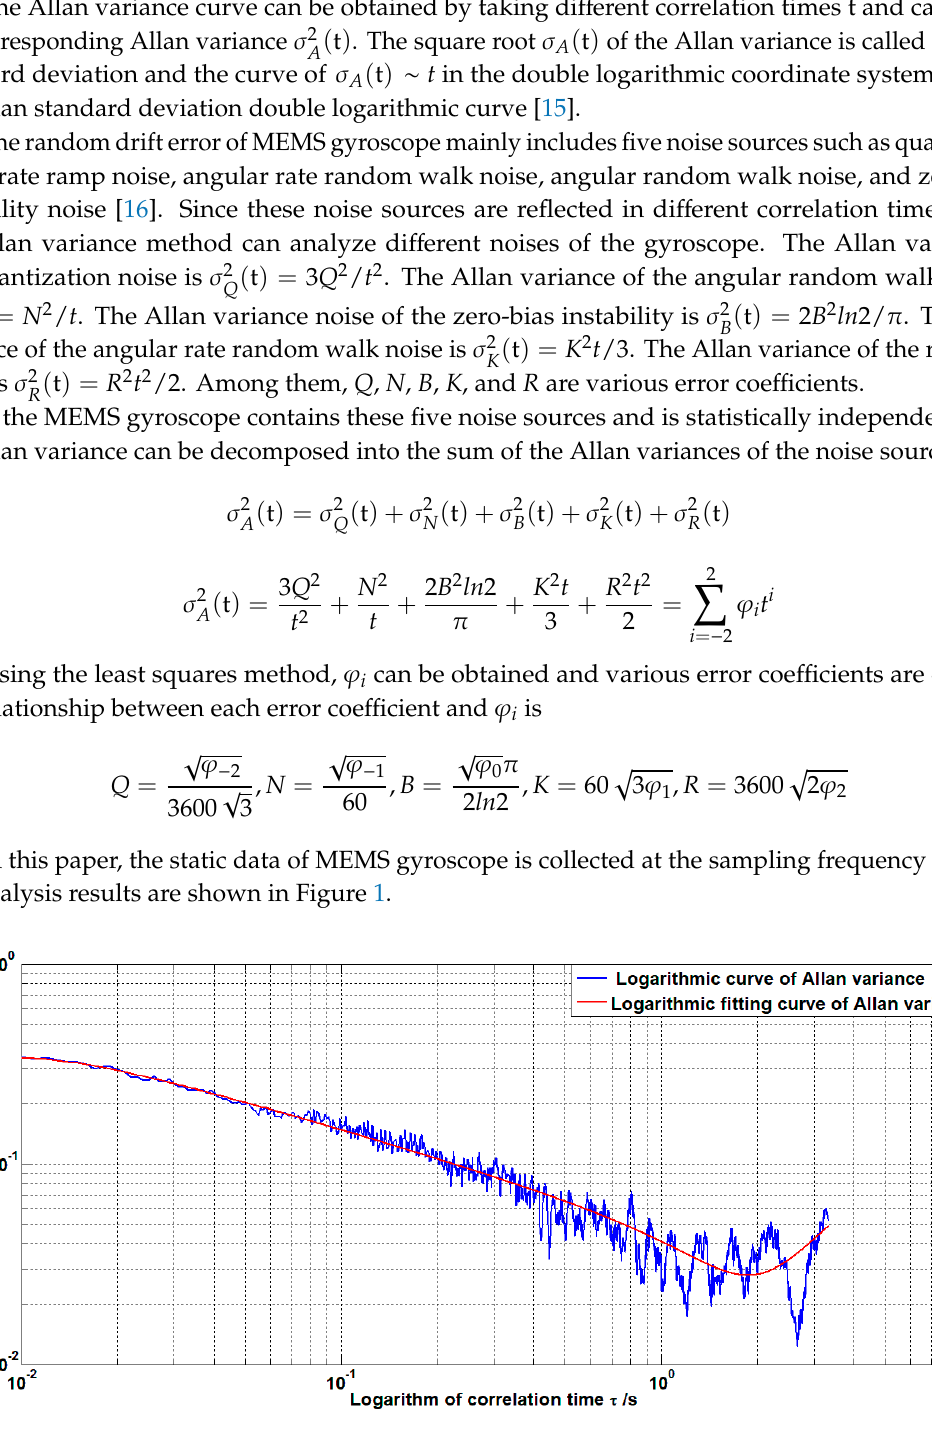
Figure 1. Allan variance logarithmic curve.